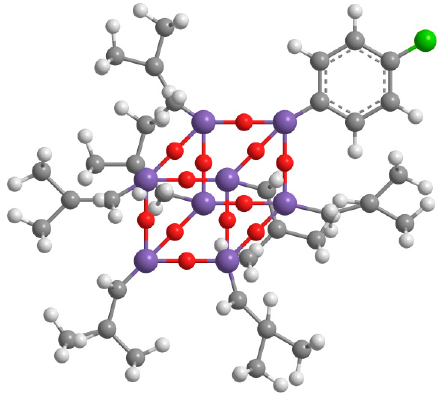
Figure 1. The chemical structure of the 4-chlorophenyl hepta isobutyl–polyhedral oligomeric silsesquioxane (POSS)